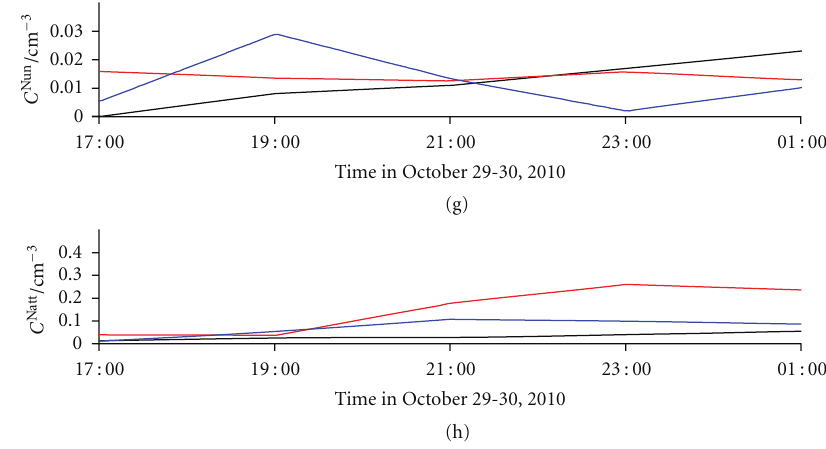
Figure 15: Time run of: (a) total number concentration of general aerosol particles ( C N (tot)) and geometric mean values of their diameters gen ( d GM ), (b) activity concentration of radon ( C A ) and equilibrium equivalent activity concentration of radon decay products ( C A ), (c) Rn RnDP number fraction of particles smaller than 10 nm ( x gen ( < 10)) and smaller than 20 nm ( x gen ( < 20)), (d) activity fraction of the unattached , RnDP ( f un ) and number fraction of the unattached RnDP ( x un ), (e) activity concentrations of the unattached RnDP atoms ( C Aun 218 Po C Aun C Aatt C Aatt C Aatt C Aun 214 Pb , and 214 Bi ), (f) activity concentrations of the attached RnDP atoms ( 218 Po , 214 Pb , and 214 Bi ), (g) number concentrations of , C Nun 214 , and C Nun 214 ), and (h) number concentrations of the attached RnDP atoms ( C Natt 218 , C Natt 214 , and the unattached RnDP atoms ( C Nun 218 Pb Bi Pb Po Po C Natt 214 Bi ), in indoor air for the period October 29-30 (periods of toasting bread in the kitchen from 20:05 to 20:15 and from 20:45 to 20:55 on October 29).